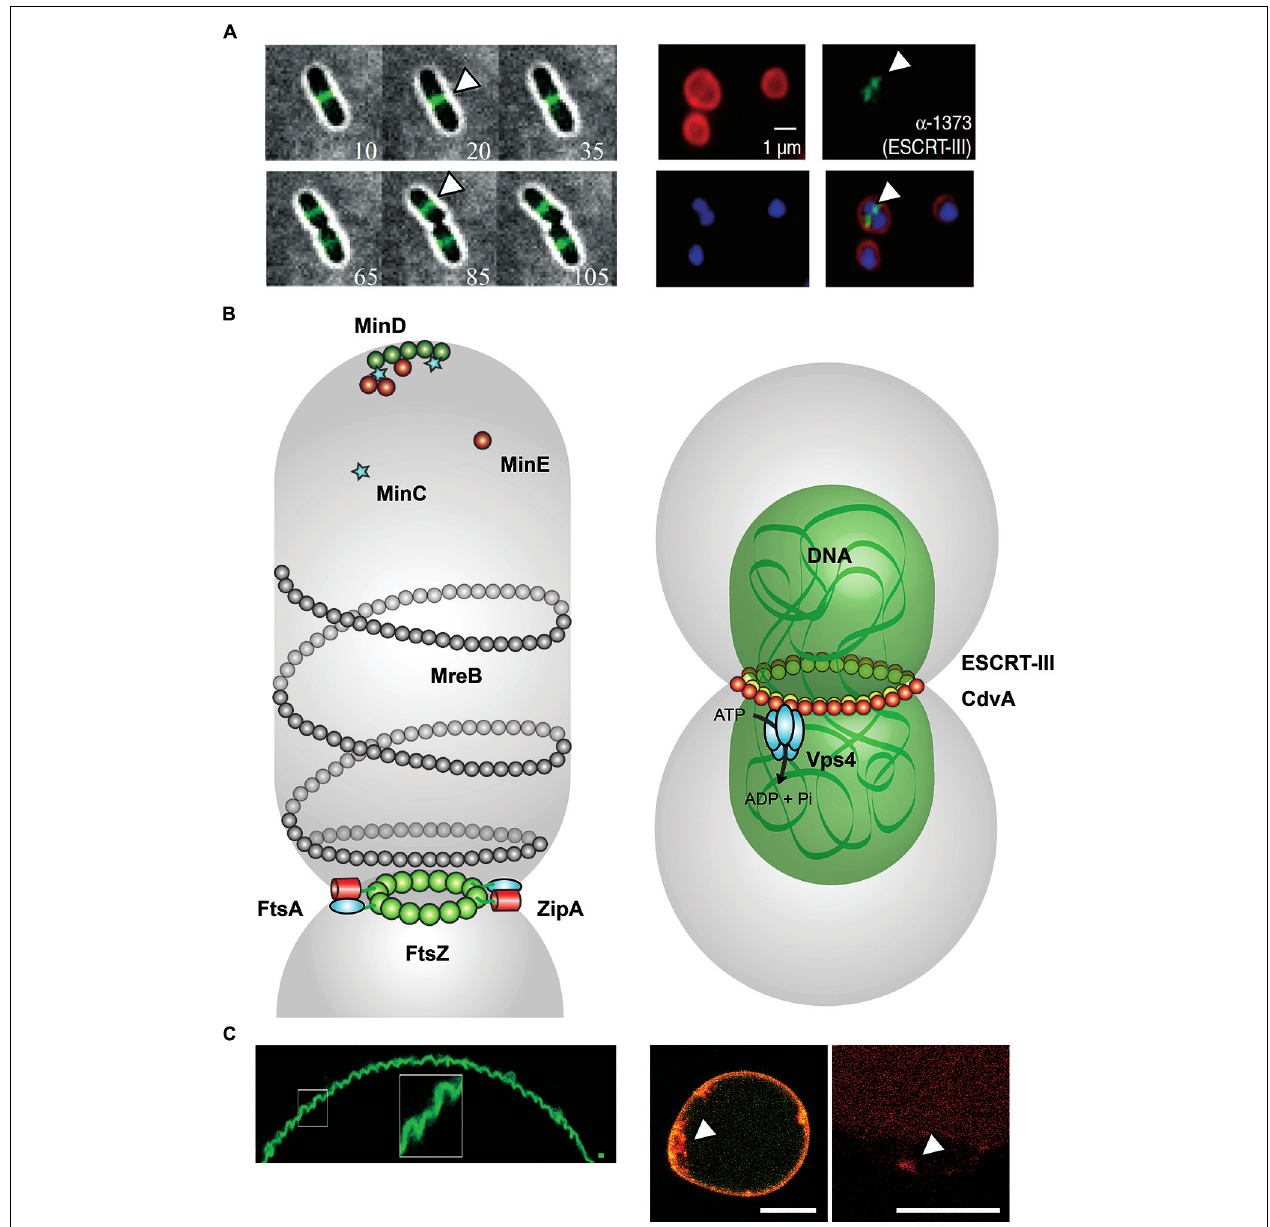
FIGURE 1 | Comparison between FtsZ- and ESCRT-III mediated cell division. (A) Left: Montages from time-lapse movies of Escherichia coli cells expressing FtsZ–GFP during cell division. At each time point, the fluorescence image (green) was overlaid with the corresponding bright-field image (gray) and the time (in minutes) displayed in the bottom corner. FtsZ (white arrowheads) forms a clear band at mid-cell early and remains there throughout the division process (Buss etal., 2013). Right: Localization of ESCRT-III in Sulfolobus acidocaldarius . Representative images show the FM4-64X staining for membrane (red), DAPI staining for DNA (blue), antibody labeling of ESCRT-III, and merged images. ESCRT-III localization is visualized by white arrowheads. Scale bar, 1 μ m (Samson etal., 2008). (B) Left: FtsZ-mediated cell division in Escherichia coli . During the initial stage of proto-ring assembly, FtsZ (green) is located to mid-cell by the oscillating Min waves [MinD (dark green), MinE (dark red), and MinC (light blue stars)]. FtsZ attaches to the membrane-associated FtsA (cyan). ZipA (red) binds competitive with FtsA to FtsZ. ZipA–FtsZ binding also increase membrane